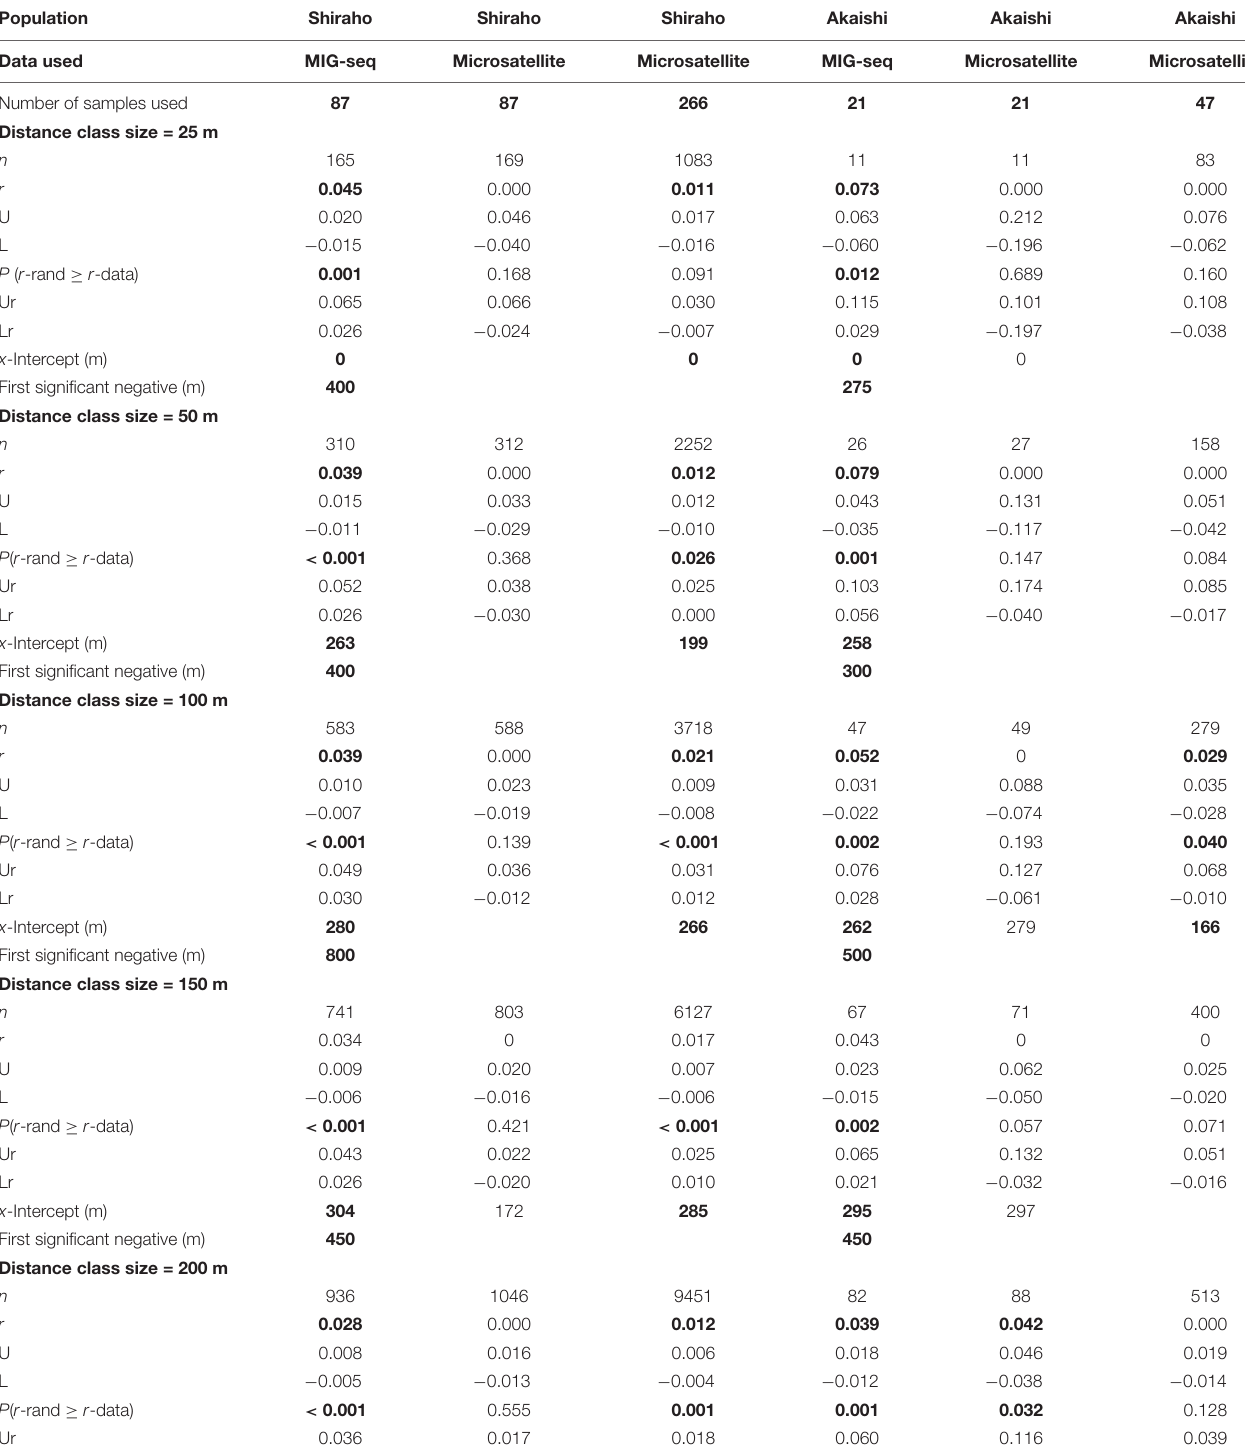
TABLE 1 | The results of spatial autocorrelation of Heliopora coerulea and for the analysis with distance class sizes of 25, 50, 100, 150, and 200 m. Population Shiraho Shiraho Shiraho Akaishi Akaishi